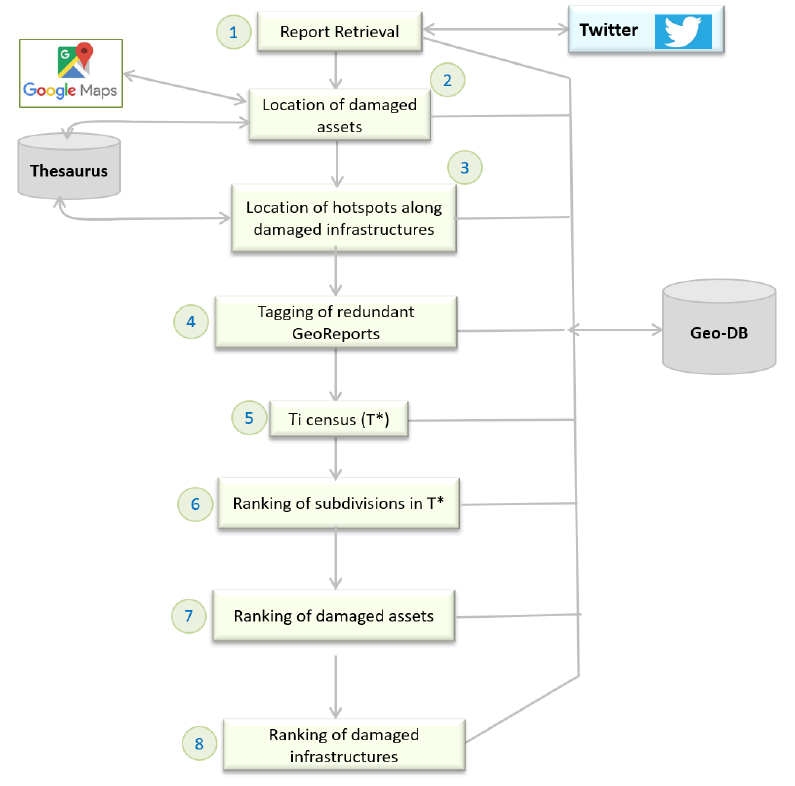
Figure 9. The steps to be